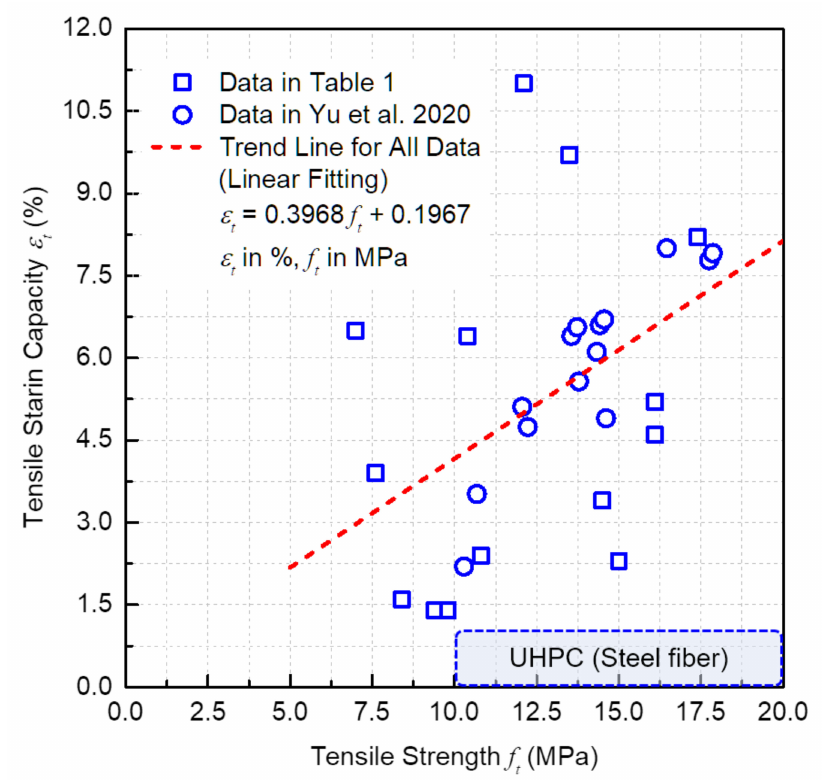
Figure 3. Tensile strain capacity vs. tensile strength data from Table 1 and reference